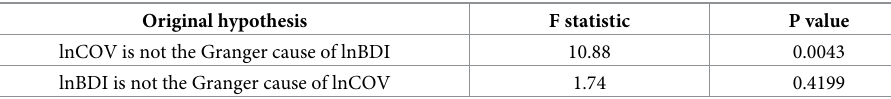
Formula (8) can be obtained by simultaneous Formulas (6) and (7)